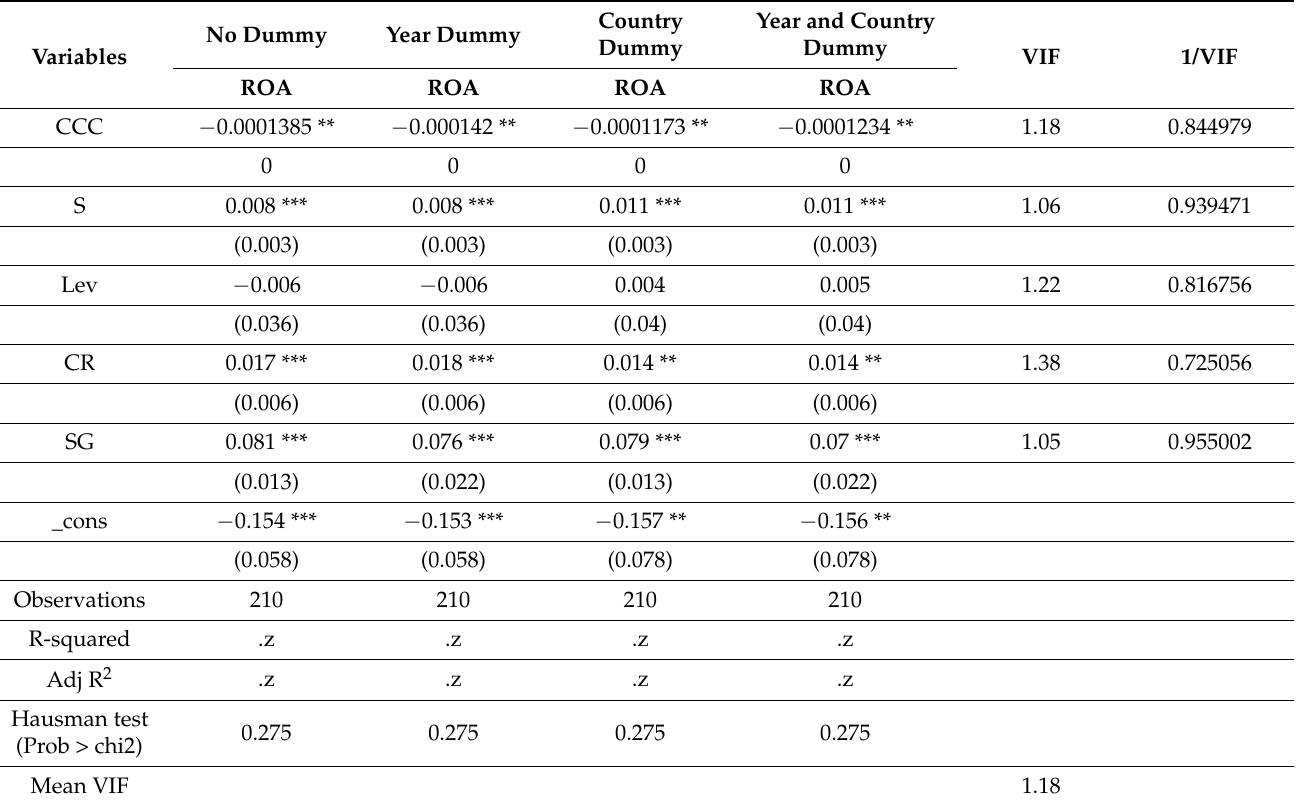
Table 13. Results of the random effects of CCC on ROA, as per panel regression (pandemic period,